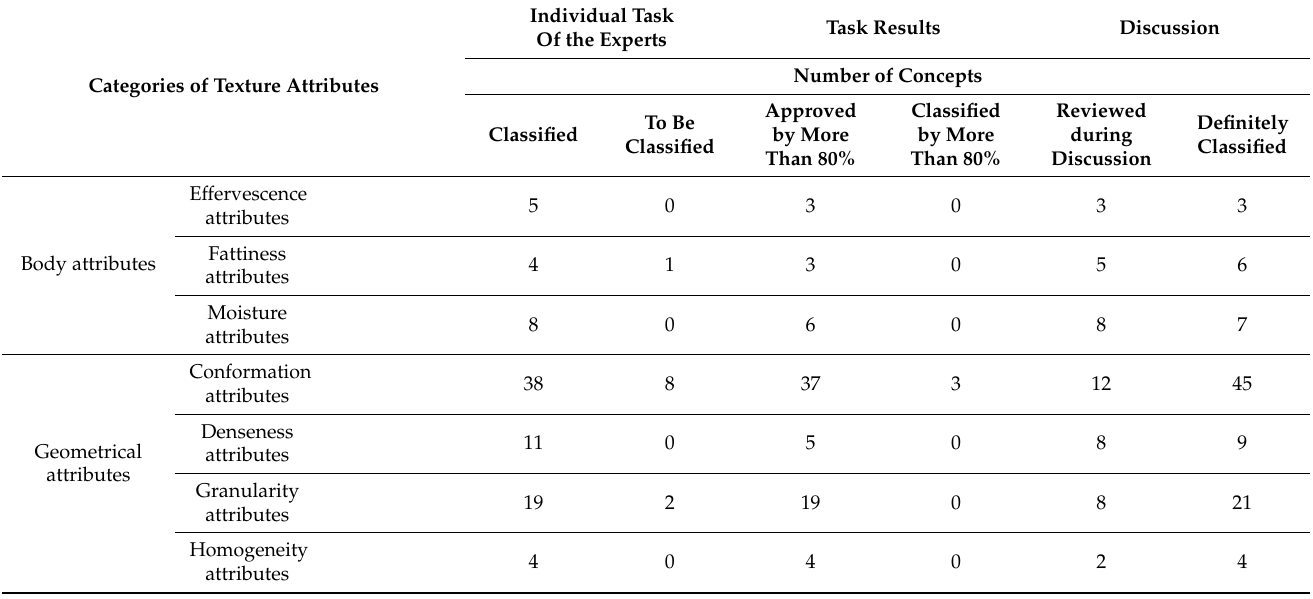
Table 4. Synthesis of task of experts on texture concepts. For each category of texture attributes, we offer the number of concepts already classified and that could be modified by experts and the